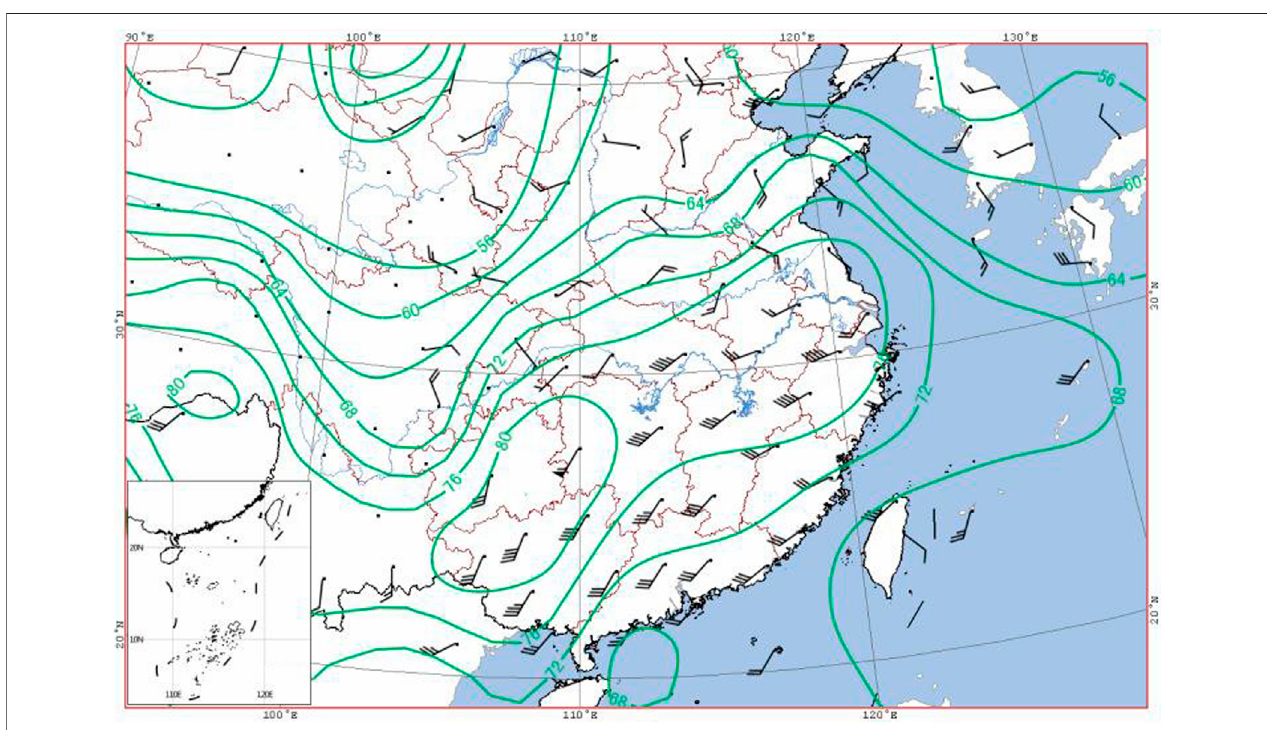
FIGURE 6 | Wind fi eld and pseudo equivalent temperature fi eld of 850 hPa at 08:00 on July 10, 2010 (green isolines).